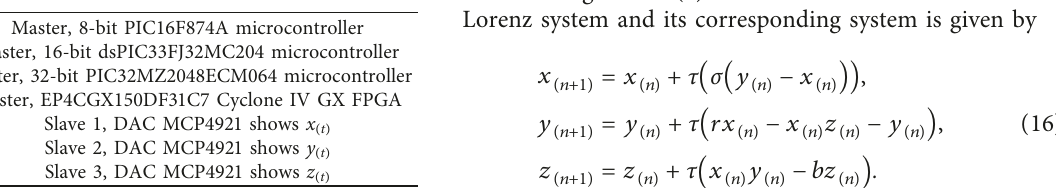
Figure 4: RMSE comparison of trajectory performance of state x of five 3D CSs (1)–(5) in their CVs with respect to their DVs using the NAs (6)–(13). Table 6: Hardware description of the ES for V1–V4. Peripheral